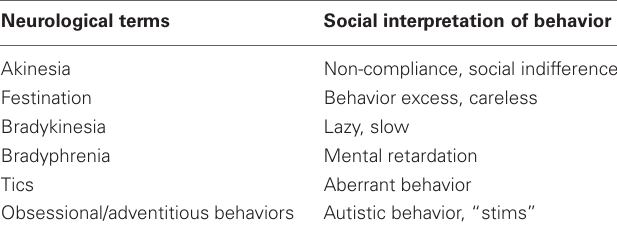
Table 2 | Differences in descriptions of